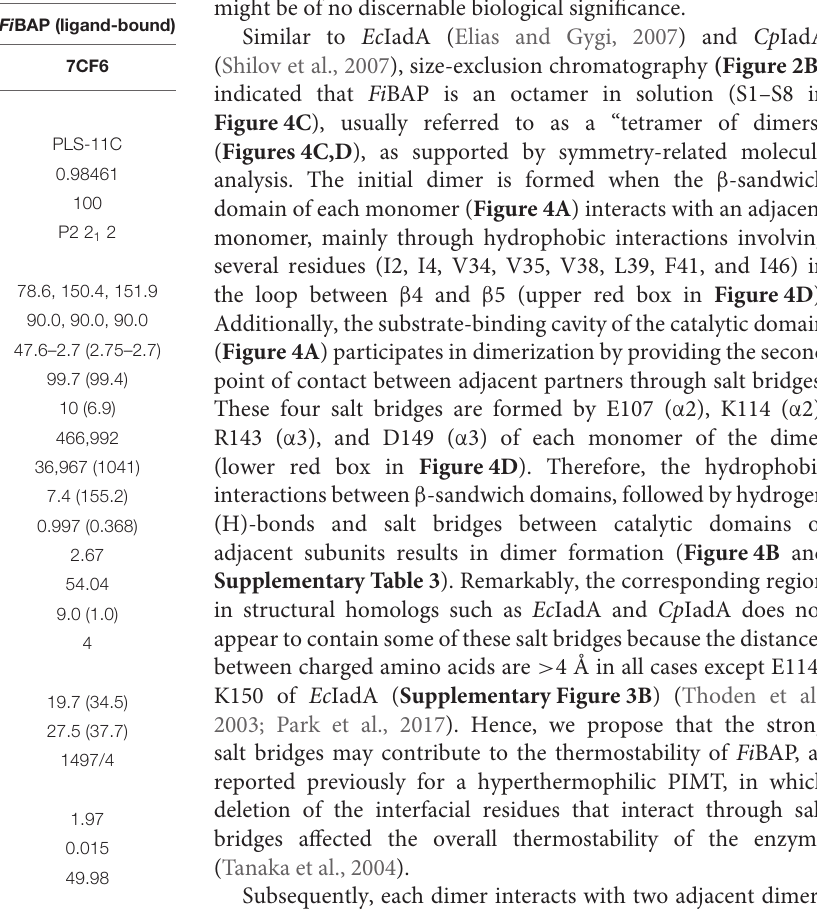
TABLE 1 | Crystallographic data collection statistics for Fi